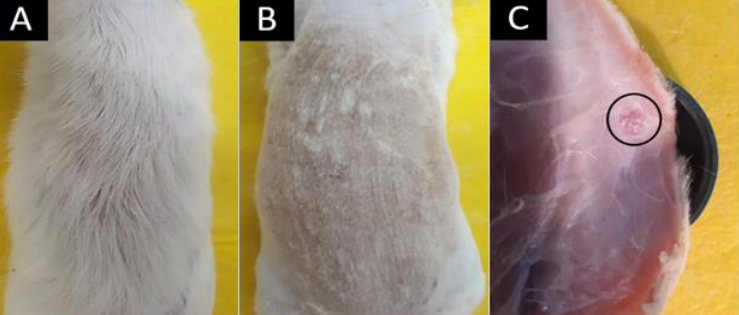
Figure 10. Macroscopic image of the implanted area. ( A ) Dorsal area with hair. ( B ) Dorsal area with a trichotomy. ( C ) Internal surface of the dorsal area. The circle corresponds to one of the sites where the materials were implanted.